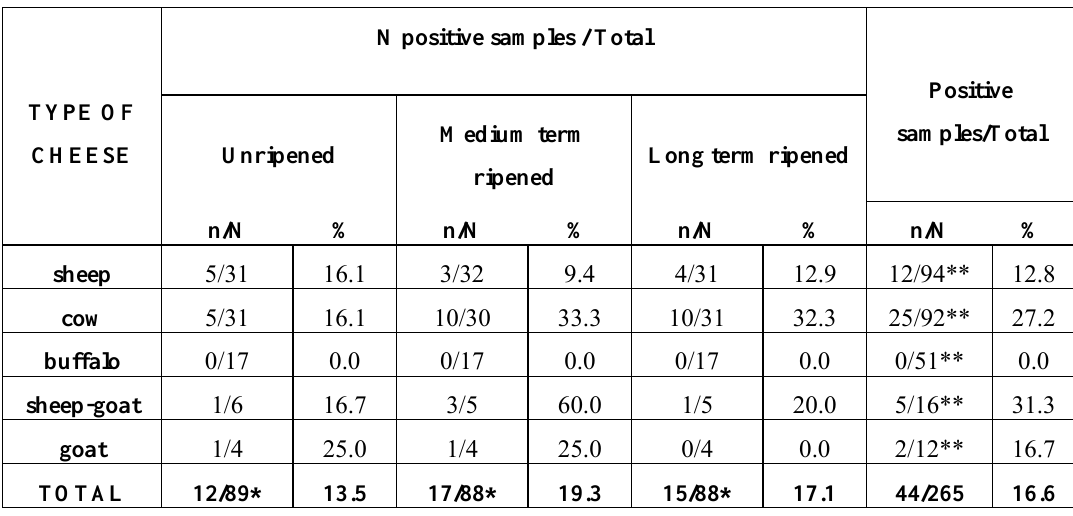
Table 1. Presence of AFM in 265 cheese samples. 1 N positive samples / Total